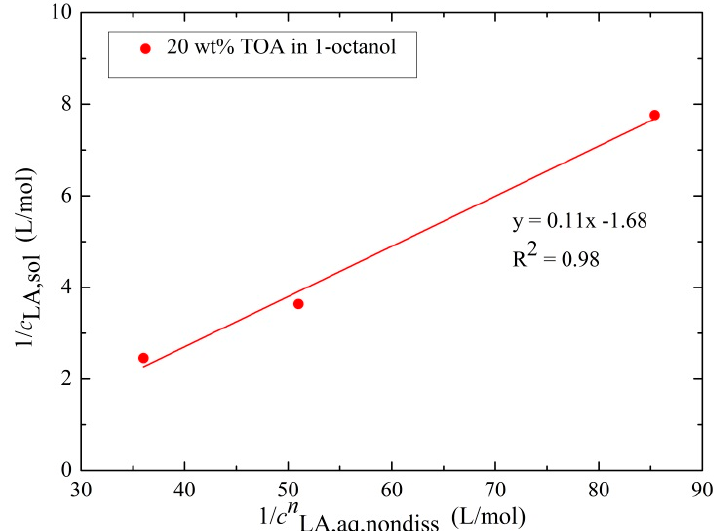
Figure 3. Determination of the extraction equilibrium constant and the degree of acid association of lactic acid (solvent with 20 wt% TOA in 1-octanol; T = 25 °C; ambient pressure) according to Equation (10).